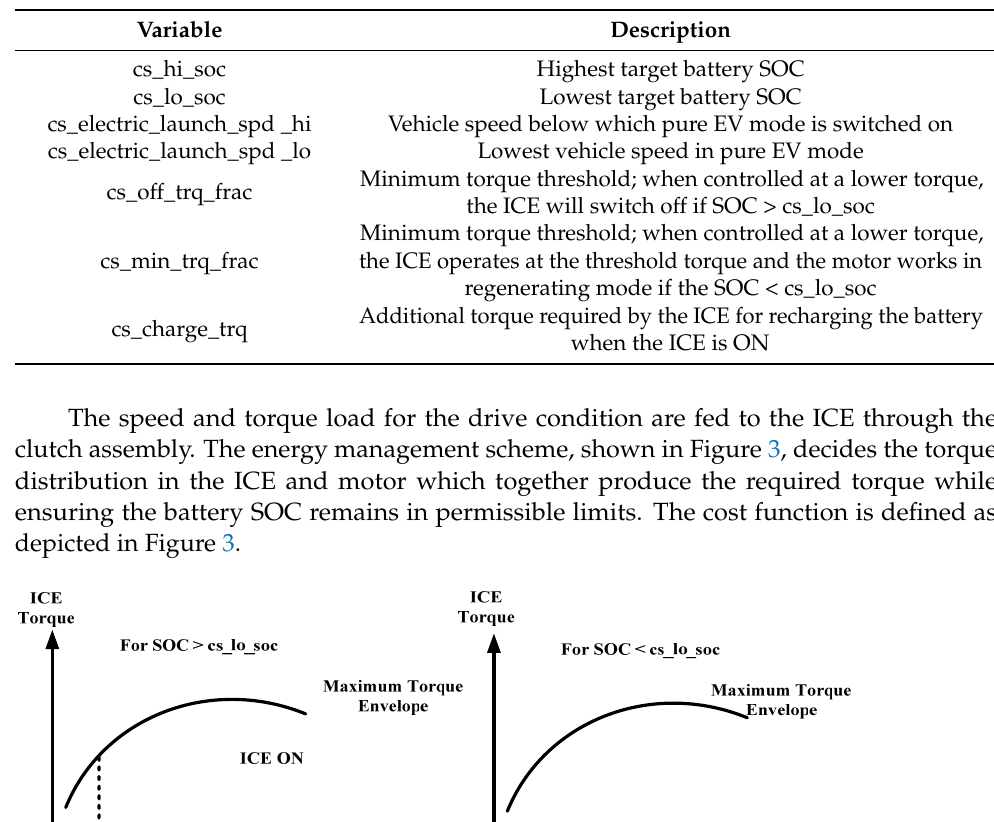
Table 1. Variables used in describing the control strategy.